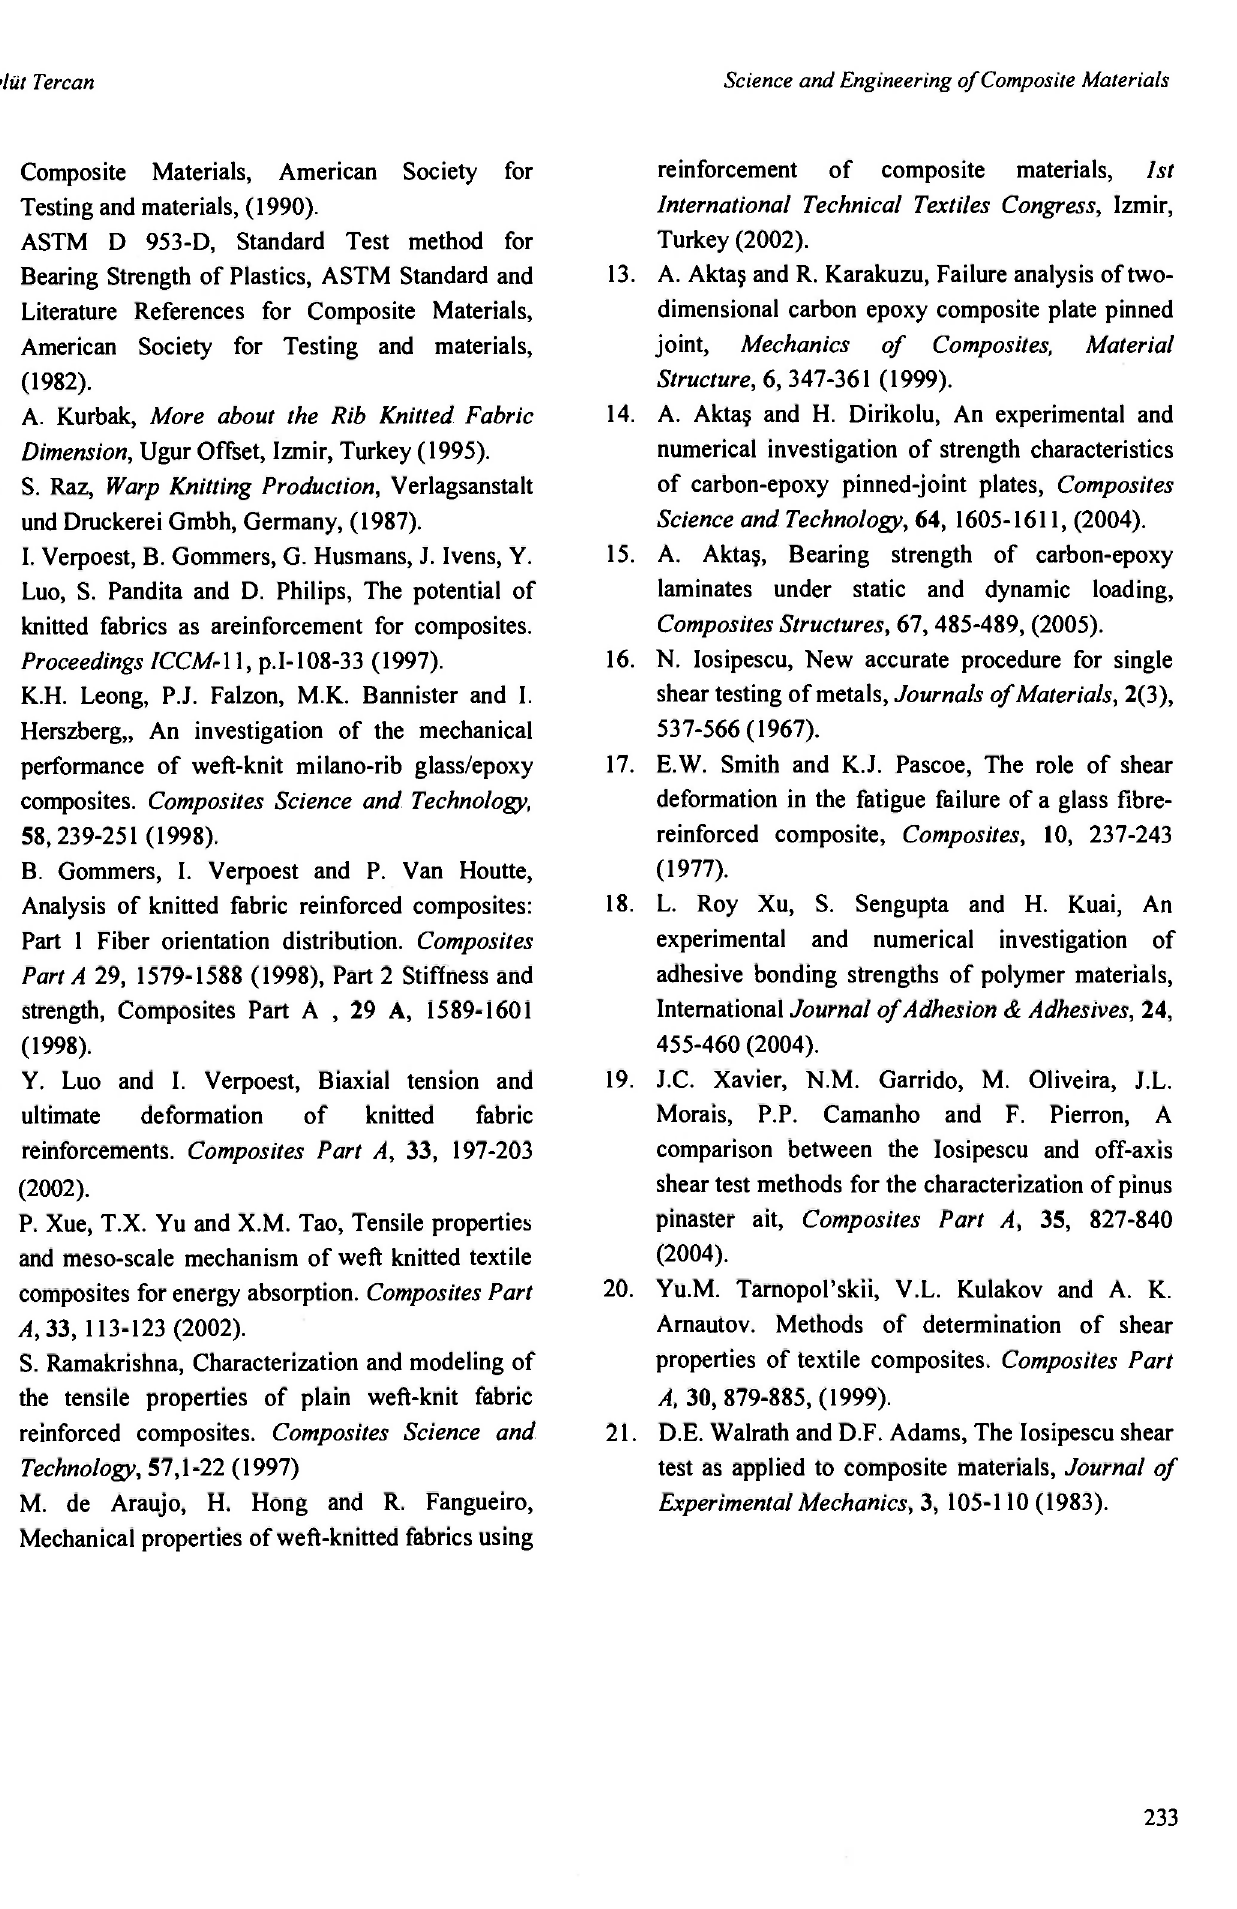
comparison between the Iosipescu and off-axis shear test methods for the characterization of pinus pinaster ait,